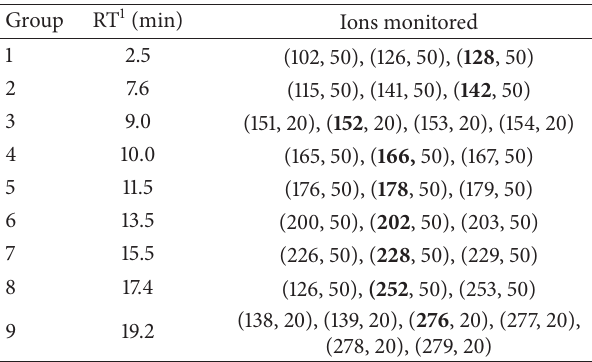
Table 2: MSD SIM method conditions; quantifier in